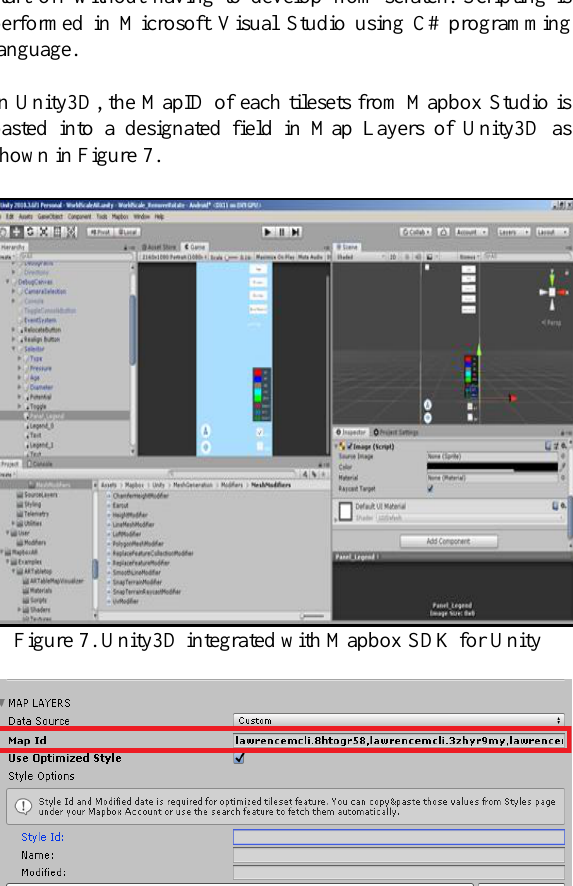
Figure 9. Mapbox’s Studio for designing map and manage data